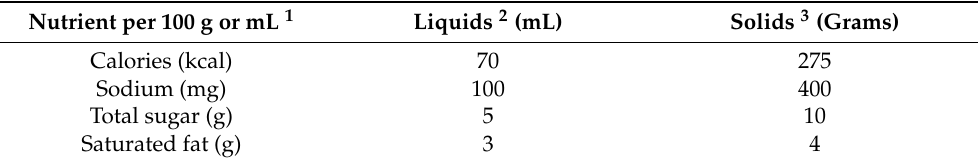
Table A2. Chilean Warning Octagon (CWO) Nutrient Profile Model (NPM) nutrient threshold criteria for foods and beverages based on Phase 3 (2019)